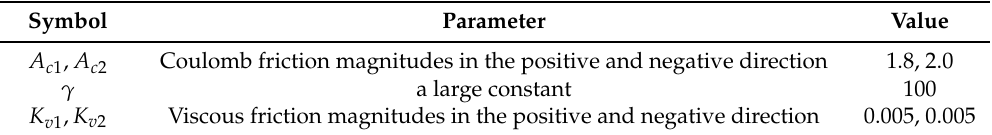
Table 4. Nonlinear friction fitting parameters.